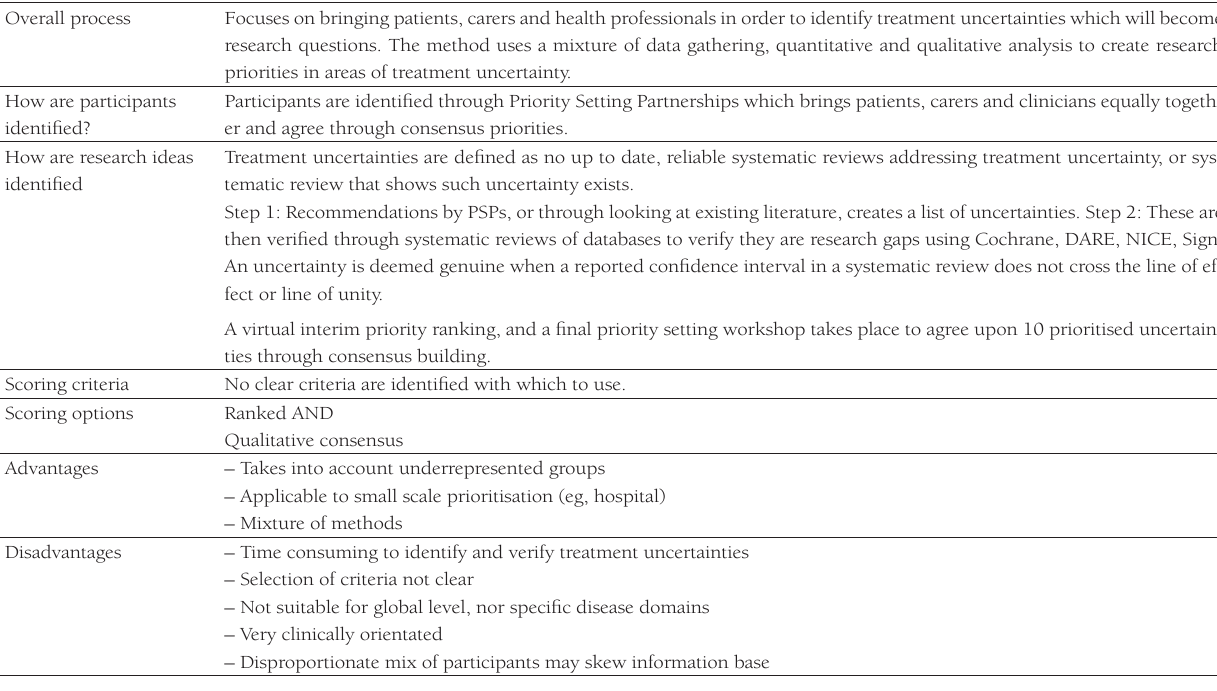
Table 3. Brief explanation of the James Lind Alliance Method [9] Overall process